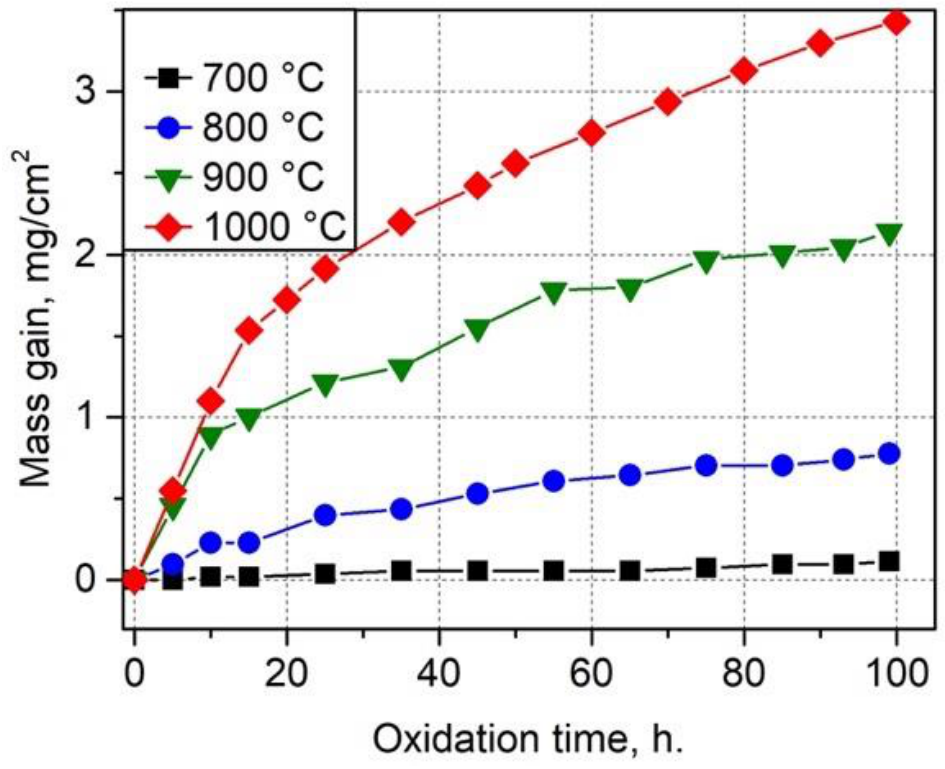
Figure 14. The weight gain of the NiAl-based coatings during 100 h of oxidation at 700, 800, 900, and 1000 °C.